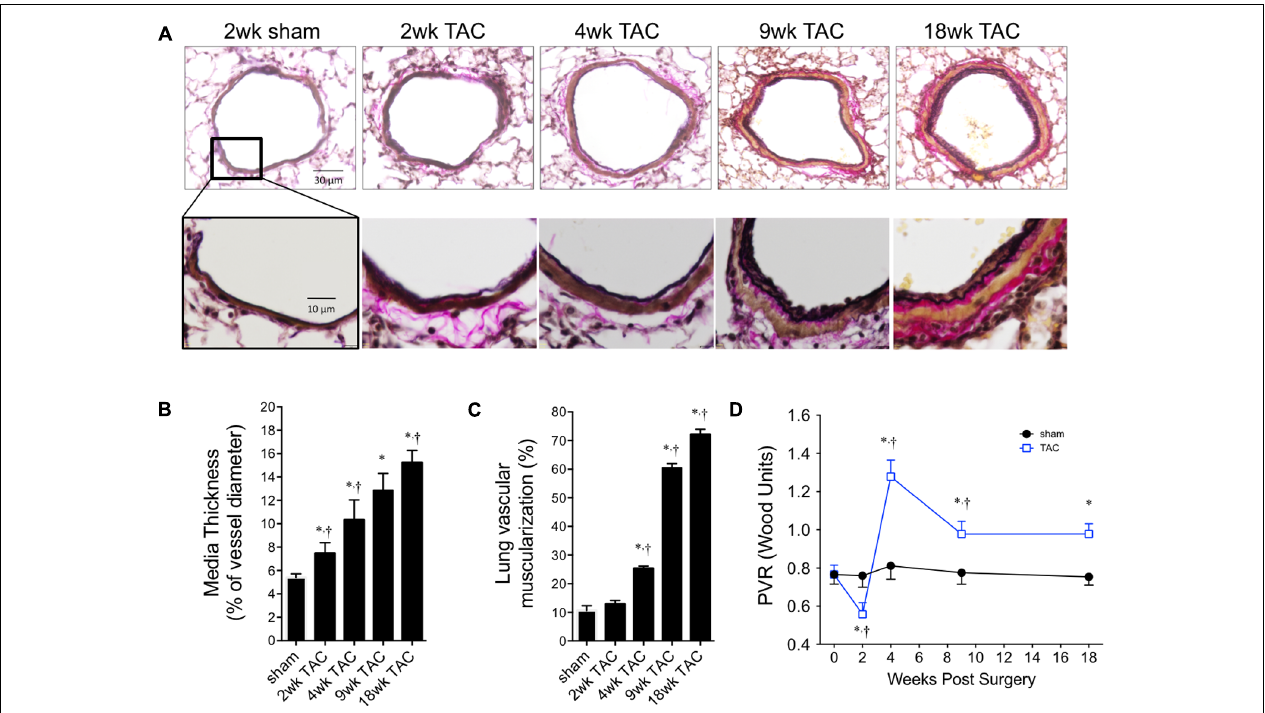
FIGURE 7 | Pulmonary vascular remodeling over 18 weeks of TAC. (A) Representative cross-sectional images of whole pulmonary arteries (top panel) and vessel walls (bottom panel). (B) Thickness of vascular media was calculated as a percent of external diameter to normalize for varying vessel sizes. (C) Percent of muscularized small arterioles ( < 35 µ m) in the lung. Sham values did not change over the 18 weeks study period and are represented as ‘sham’. (D) Pulmonary vascular resistance (PVR) was calculated from first principles; Resistance = (cid:49) Pressure/Flow. (cid:49) Pressure was the gradient between right ventricle systolic pressure and left ventricle end diastolic pressure. Flow was cardiac output. ∗ p < 0.01 vs. age-matched sham. † p < 0.05 vs. previous time point.